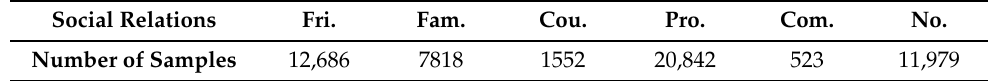
Table 3. Sample distribution of the PISC dataset.